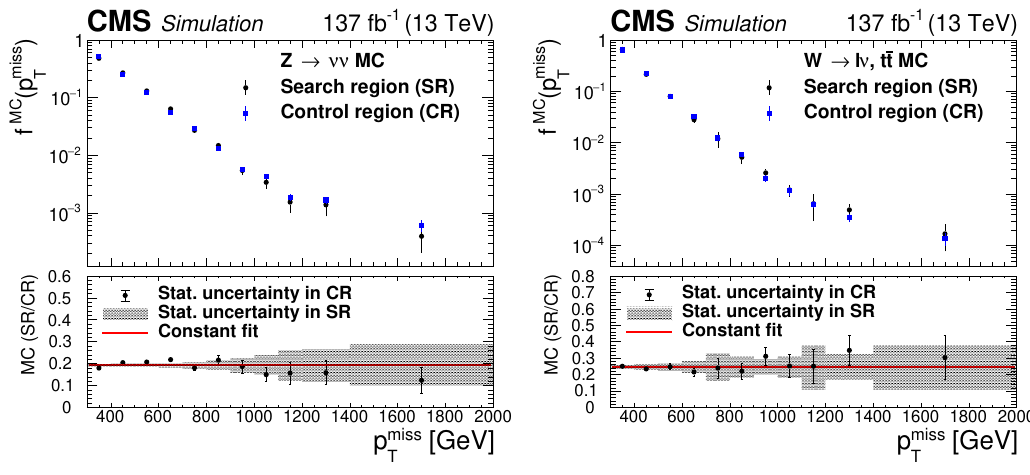
Figure 5 . Comparison of the p miss shape in the search and control regions in simulation. The T upper panels show the unit-normalized p miss distributions f MC ( p miss ) in the two regions, while the T T lower panels show the ratio of the number of events in the search region to that in the control region. This comparison is done for two main background components: Z ! (cid:23)(cid:23) (left) and tt plus W+jets (right). In the lower panel the statistical uncertainties in the search and control region yields are denoted by the shading and vertical bars, respectively, and a (cid:12)t to a constant is included to show the average